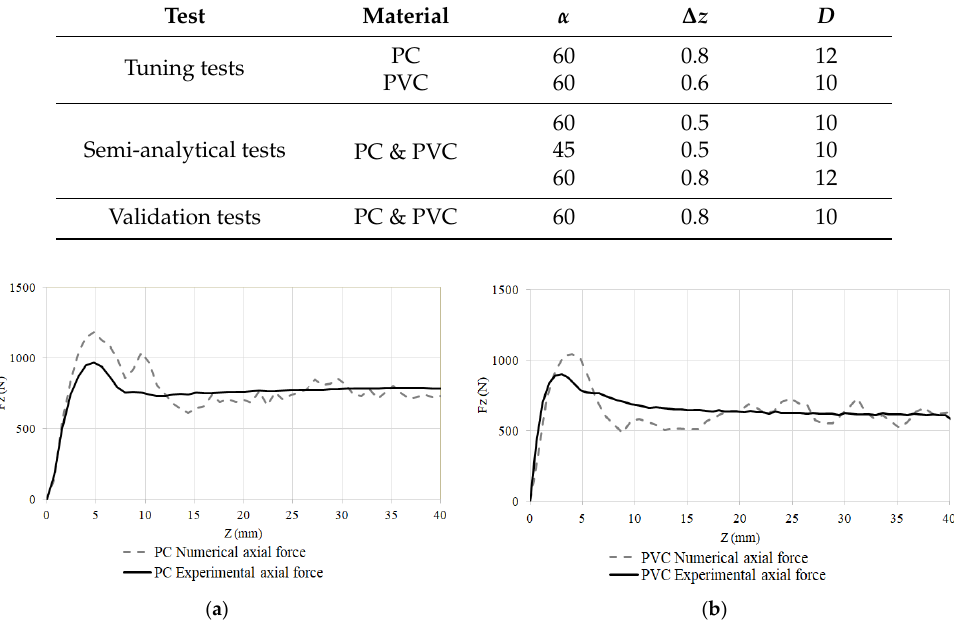
Table 3. Experimental tests conducted to define the semi-analytical and numerical model.